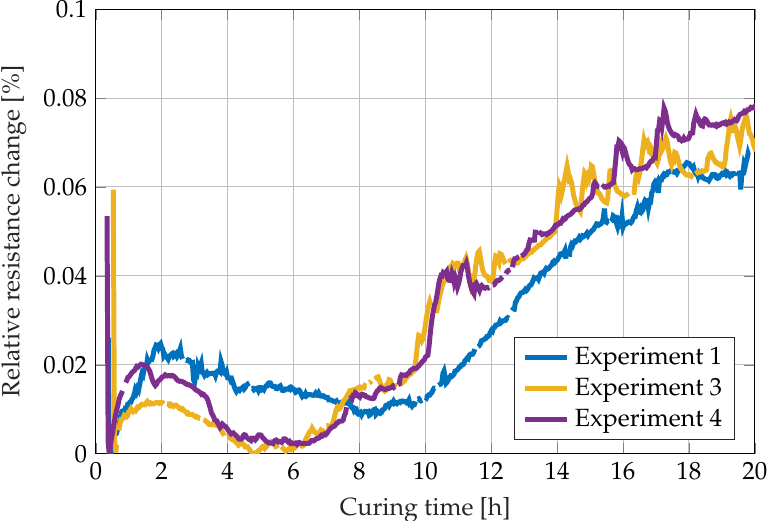
Figure 12. Strain development during the curing reaction of RIMR 426 resin with RIMH 435 curing agent measured by the relative resistance change of a commercial strain